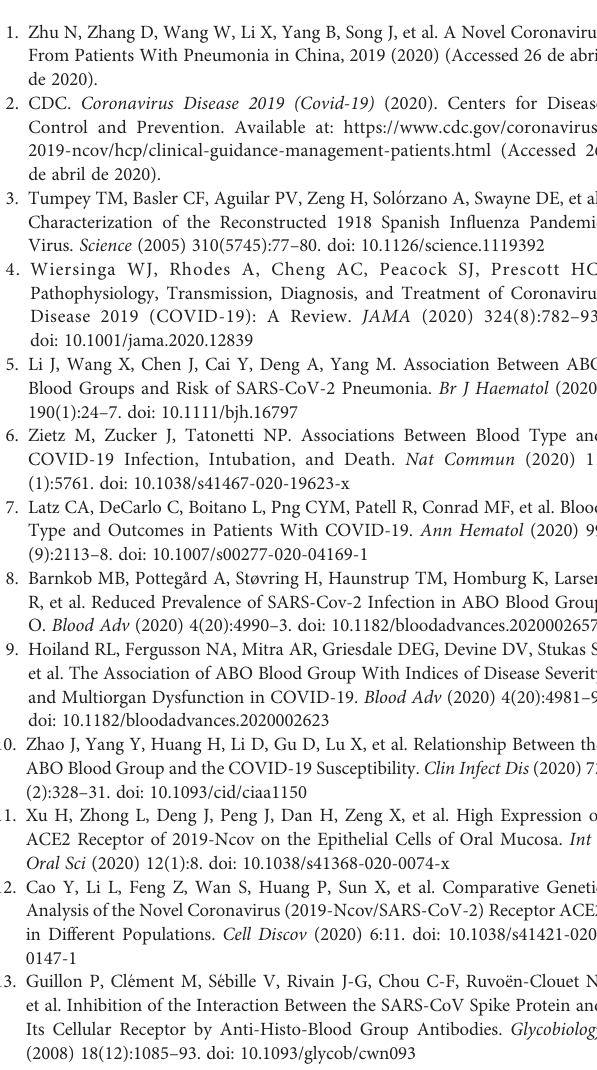
Supplementary Figure 1 | Individual logistic regression models on each cytokine. OR,oddsratio; CI, con fi denceinterval;Cit,cytokine. ORwasexpressedinlogarithmic base